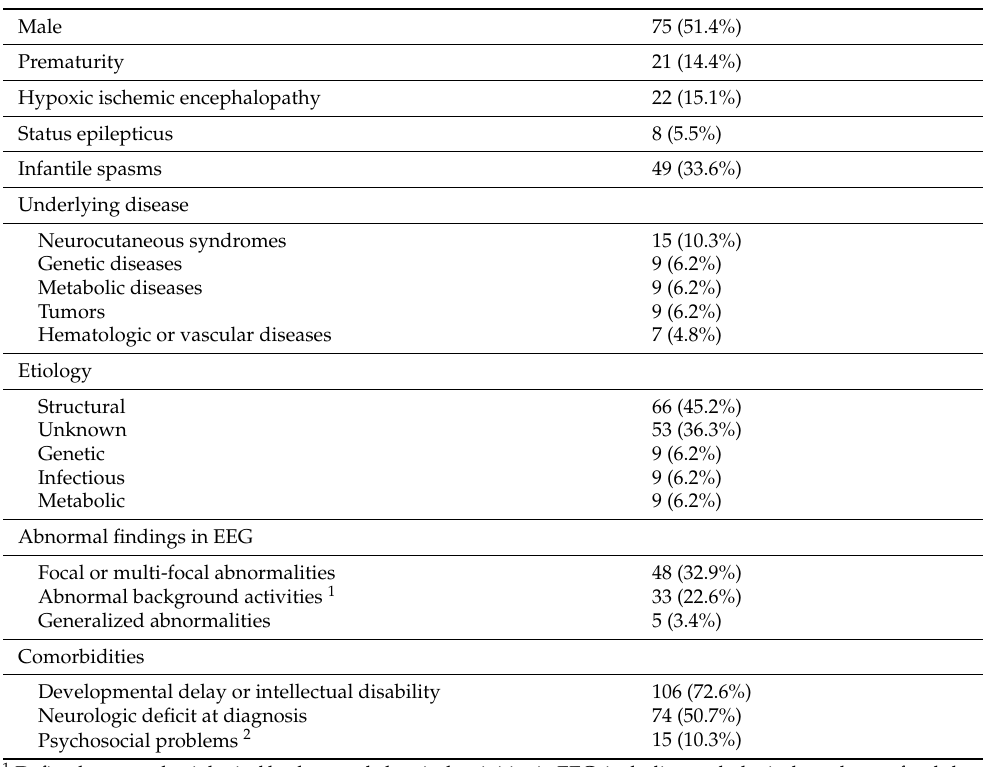
Table 1. Characteristics of 146 patients with infantile-onset